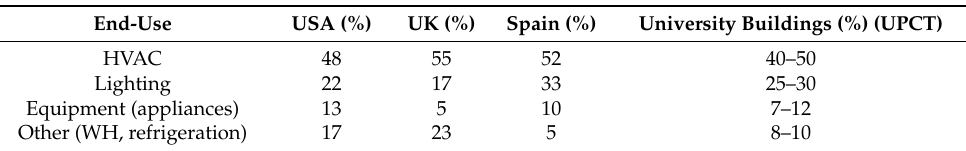
Table 1. Energy demand in office buildings by